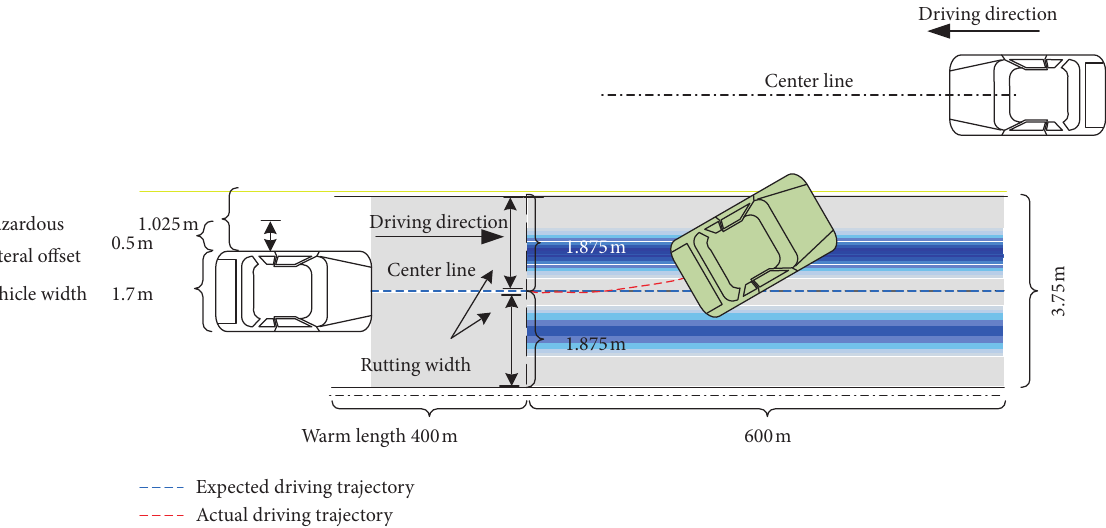
Figure 9: Hazardous lateral offset during vehicle